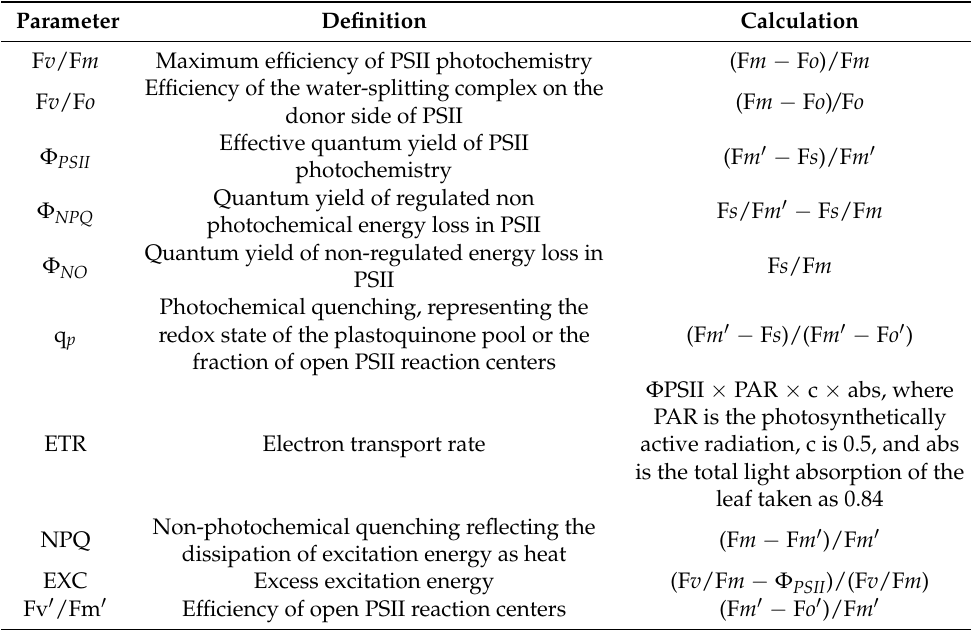
Table 1. Definitions of the measured chlorophyll fluorescence parameters.